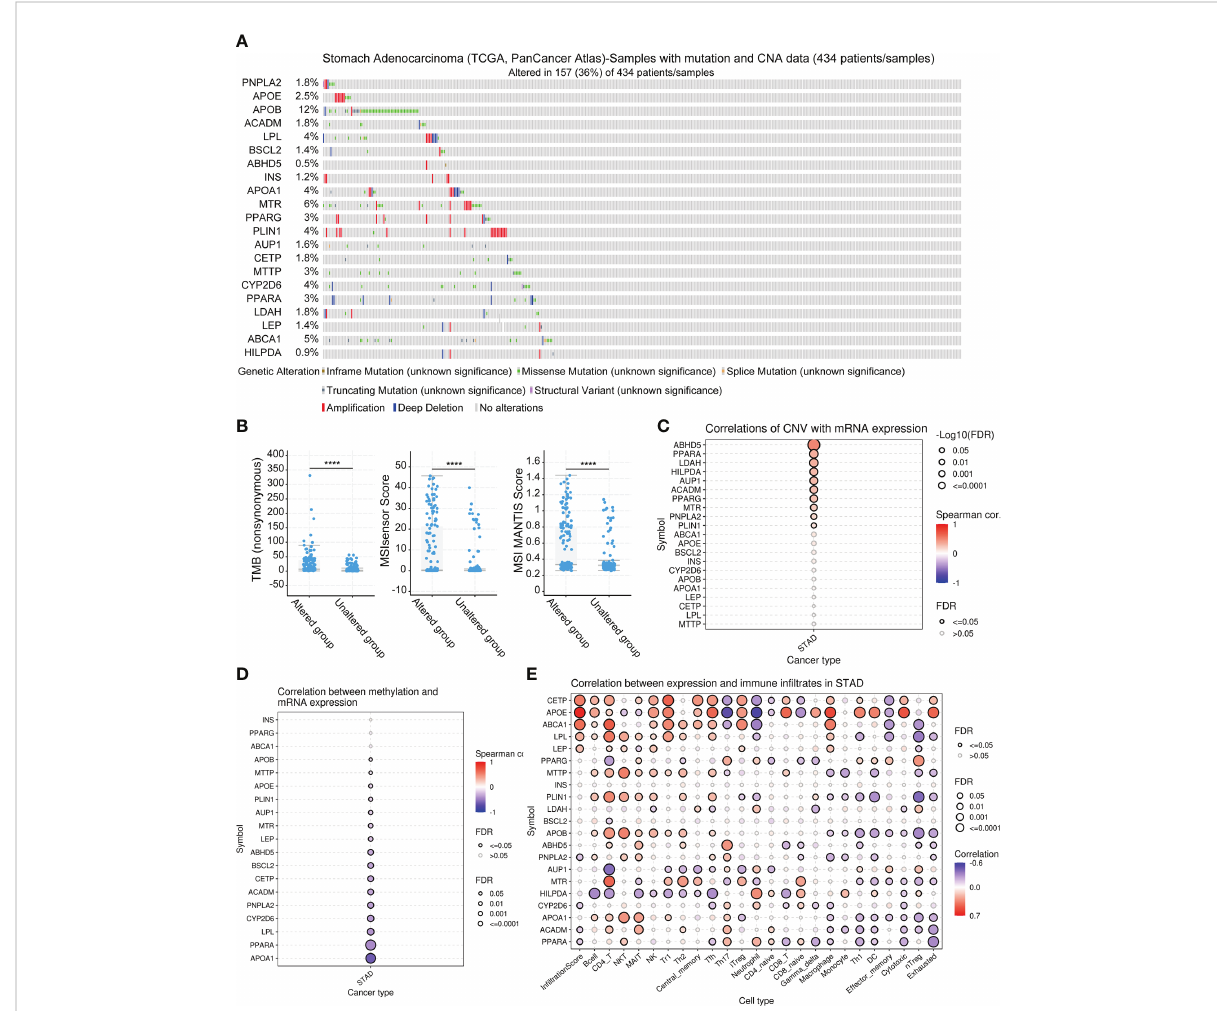
FIGURE 2 Multi-omics analysis of LDMRGs in STAD. (A) Landscape analysis of genetic alterations of LDMRGs in STAD using the cBioPortal database. (B) Differential analysis of TMB, MSI in different genetic alteration groups in STAD using the cBioPortal database. (C – E) Correlation analysis of mRNA expression levels of LDMRGs and CNV, methylation, and immune in fi ltration levels in STAD. (****: p ≤